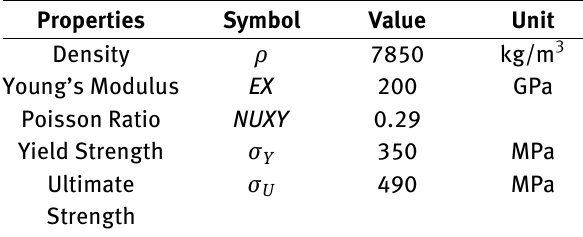
Table 4: Material properties of repair material: steel grade